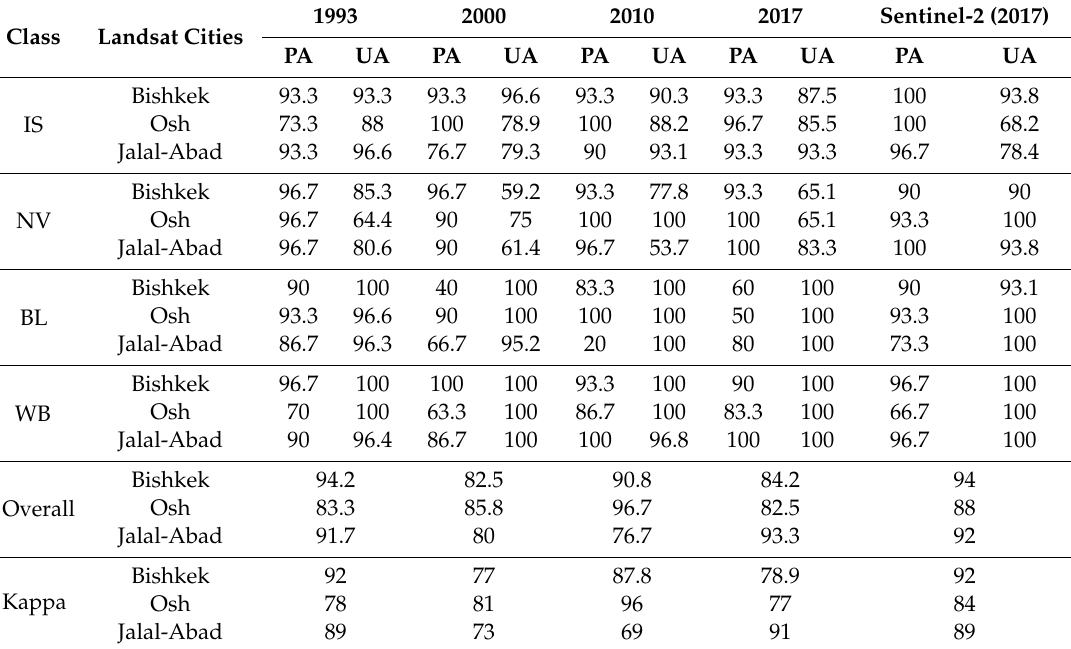
Table 2. Overall accuracy (OA) and kappa coe ffi cients (KCs) for the classifications of Landsat TM, ETM, and 8 OLI data from 1993 to 2017, and for Sentinel-2 for